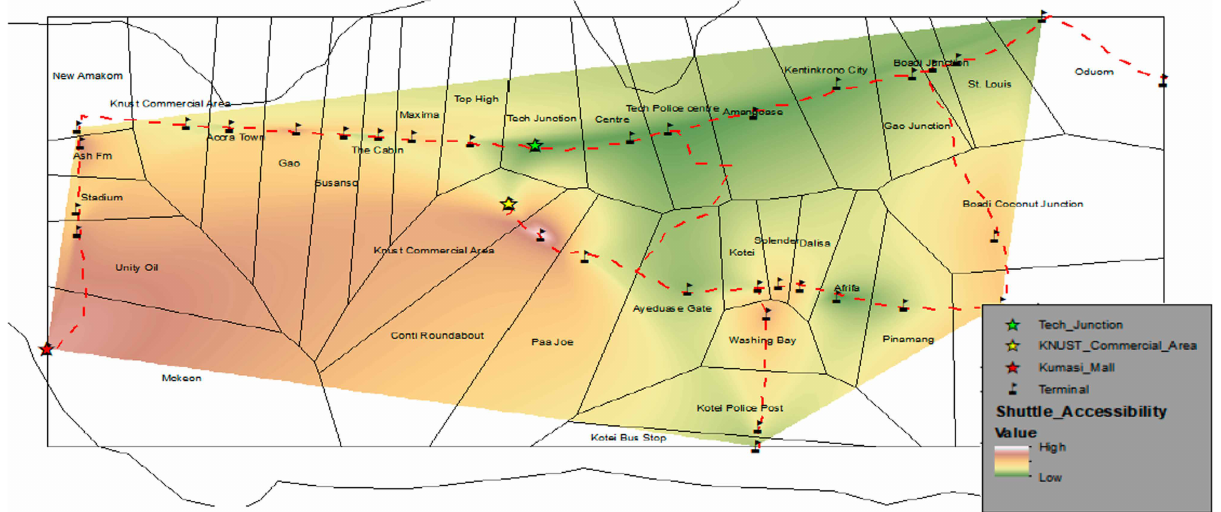
Figure 4: Accessibility level to commercial centres by public transport with green as low accessibility, pale yellow as average accessibility and brown as high